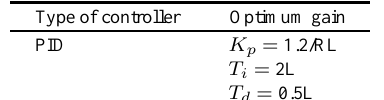
Table 1 Ziegler-Nichols Tuning for the Regulator